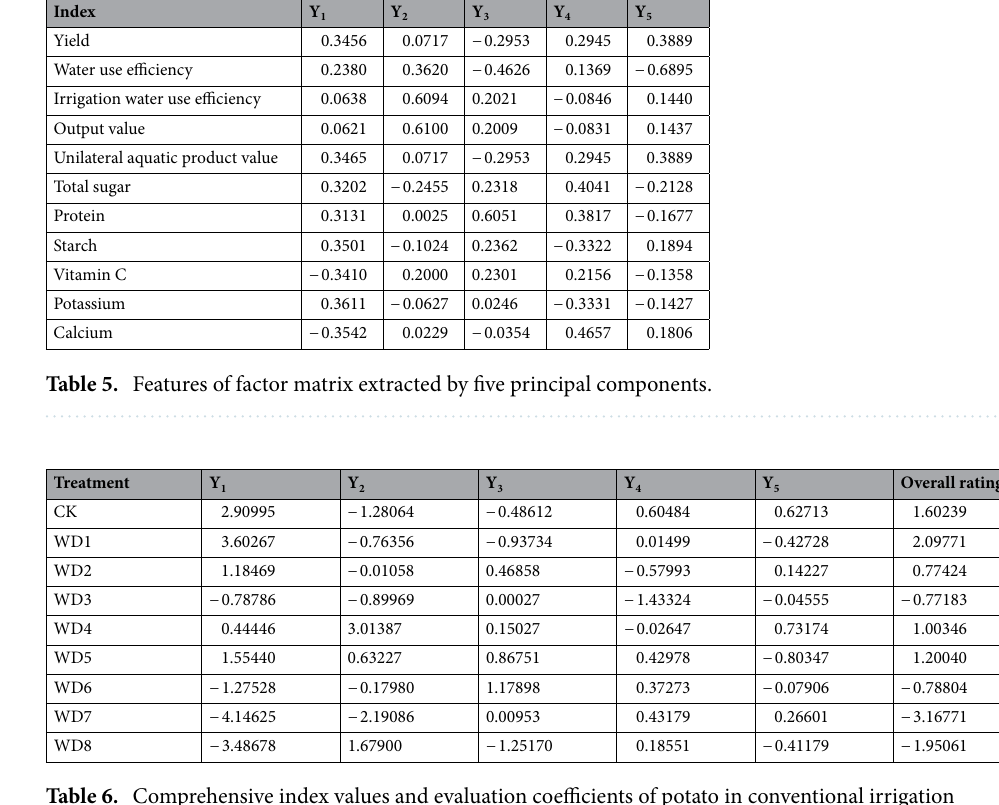
Table 6. Comprehensive index values and evaluation coefficients of potato in conventional irrigation (CK) and regulated deficit drip irrigation treatments. The positive and negative values in the table indicate their position only relative to the average. The irrigation treatments were conventional irrigation (CK) and mild or moderate water deficit during each of four stages of potato growth. Mild deficit was in treatments WD1 (seedling), WD2 (tuber initiation), WD3 (tuber bulking), and WD4 (starch accumulation); moderate deficit was in treatments WD5 (seedling), WD6 (tuber initiation), WD7 (tuber bulking), and WD8 (starch